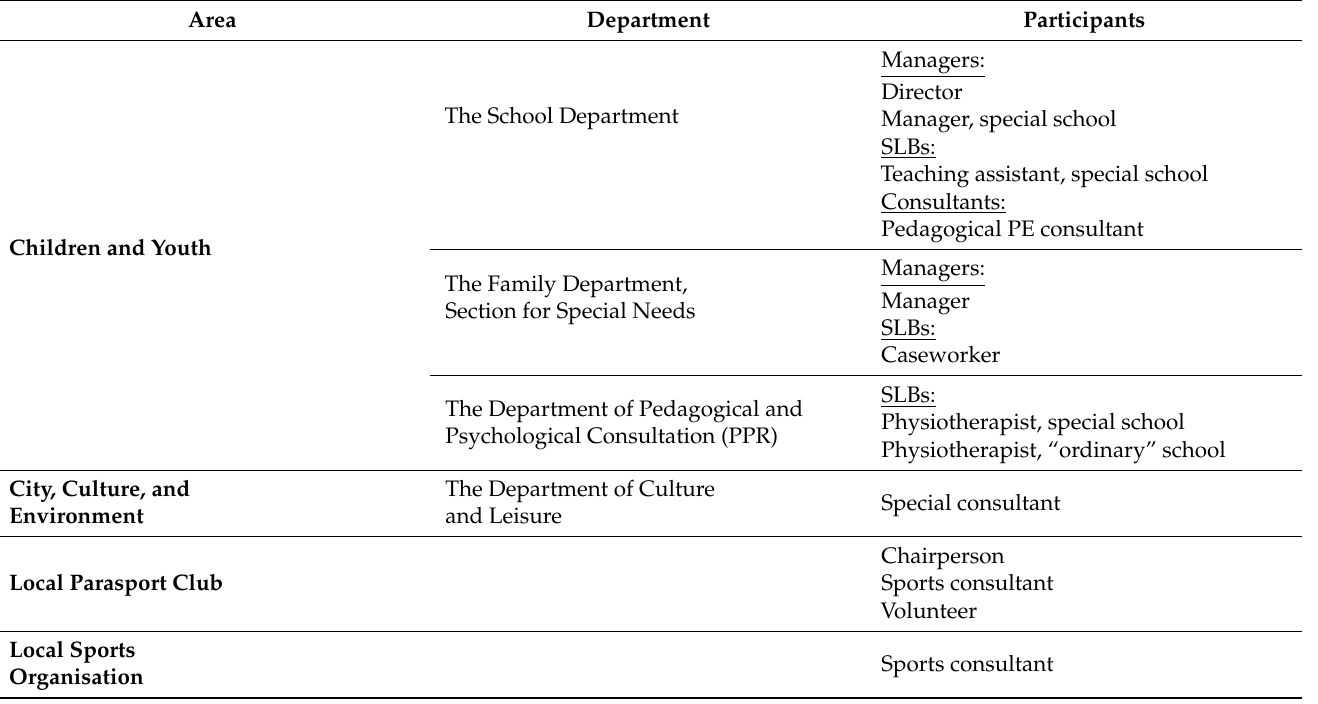
Table 1. Participants, Municipality 1 (M1).